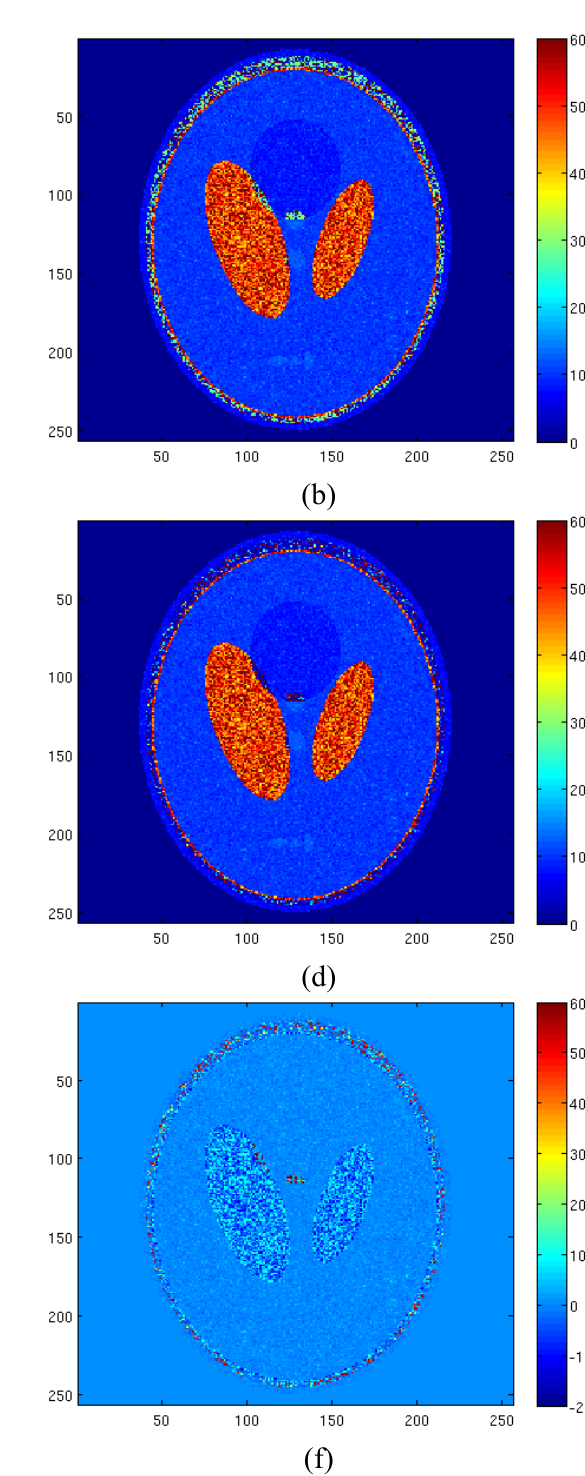
reconstruction 2